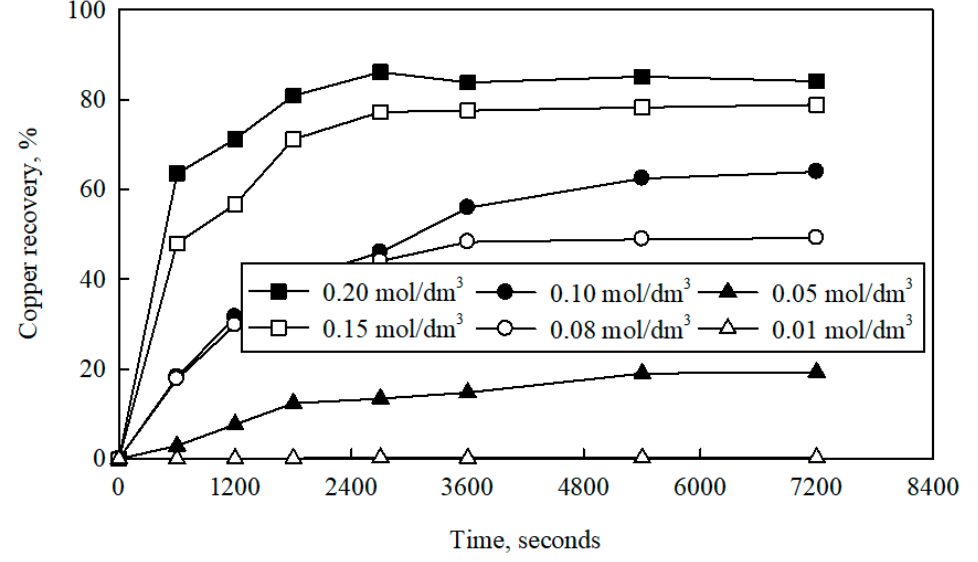
Figure 8. The e ff ect of ammonium hydroxide concentration. Working conditions: temperature = 298 K, Figure 8. The effect of ammonium hydroxide concentration. Working conditions: temperature = 298 particle size = 5 µ m, stirring rate = 500 rpm, pH = 10.5 and S / L ratio = K, particle size = 5 μ m, stirring rate = 500 rpm, pH = 10.5 and S/L ratio = 1:1000.